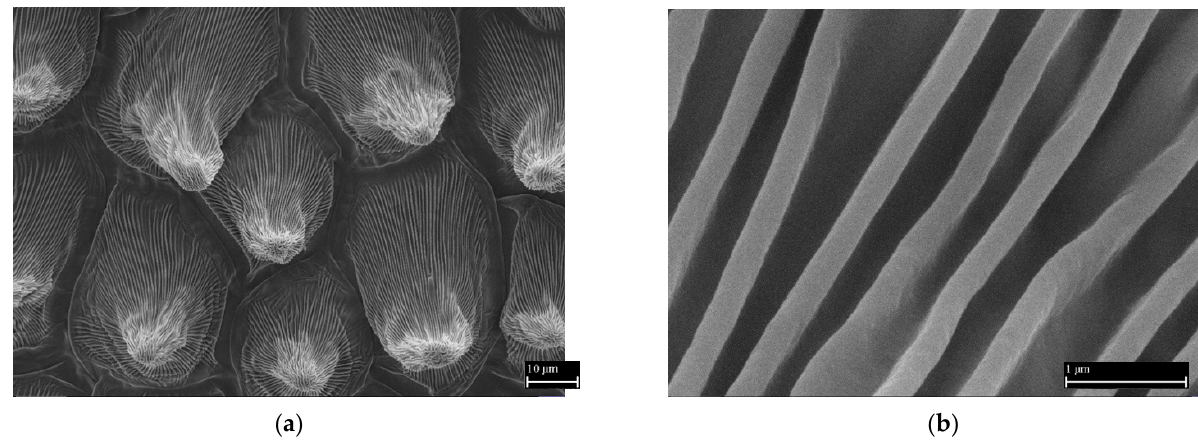
Figure 5. The surface of the crown leaves of the garden pansy (Viola x wittrockiana). ( a ) Overview microscopic image of a thin layer taken from the surface of the garden pansy crown leaf. ( b ) Detailed image of the surface of this layer with smooth sub-micrometer folds/protrusions. Reprinted from ref. [14,19,20].